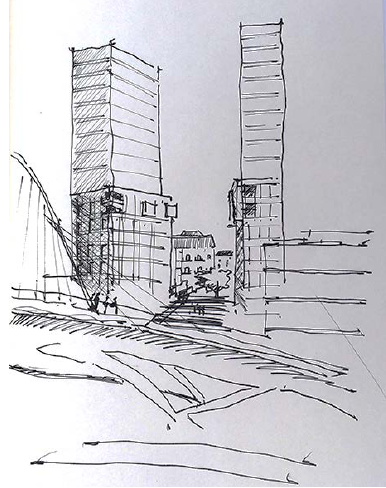
Figure 2. Sketch for Nara Centennial Convention Hall, 1992.